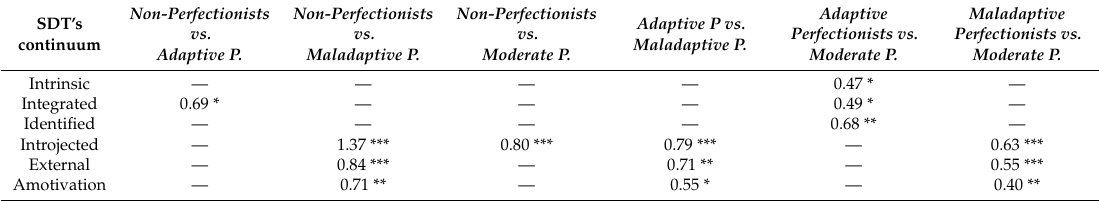
Table 4. Cohen’s d indexes for post-hoc contrasts between the mean scores obtained by the four classes on the six motivational regulatory styles. Non-Perfectionists SDT’s continuum